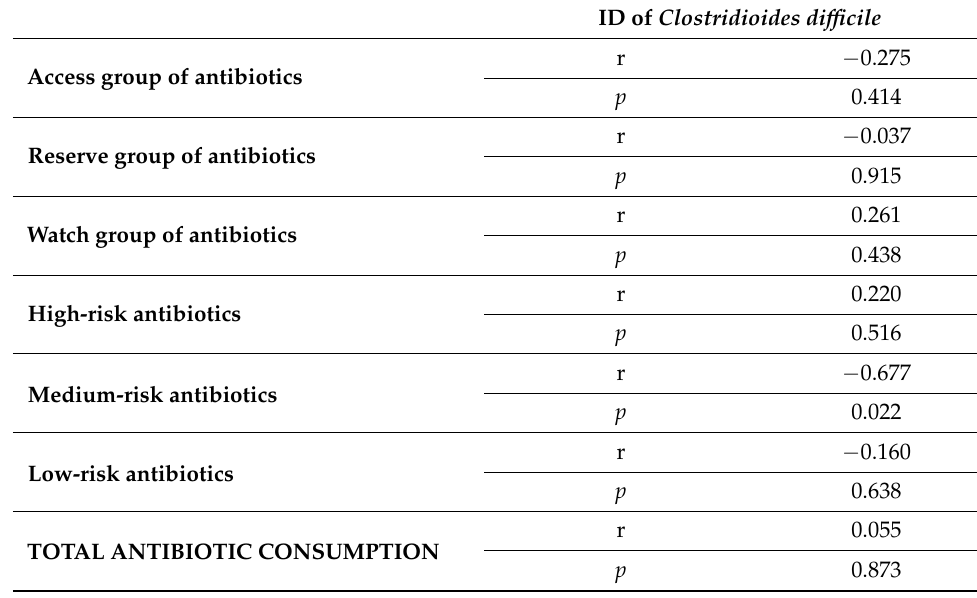
Table 5. Correlation between consumption of antibiotics classified according to the WHO Access, Watch, and Reserve classifications and the risk of Clostridioides difficile infection with the incidence density (ID) of Clostridioides difficile in the Serbian tertiary university hospital from 2011 to 2021. ID of Clostridioides